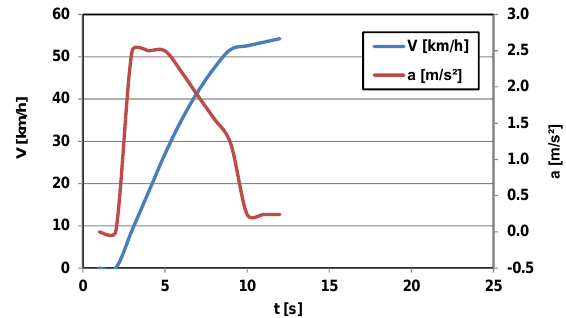
Fig. 7. Characteristics of speed and acceleration of the vehicle as a func- tion of simulation time; a = 2.5 m/s 2